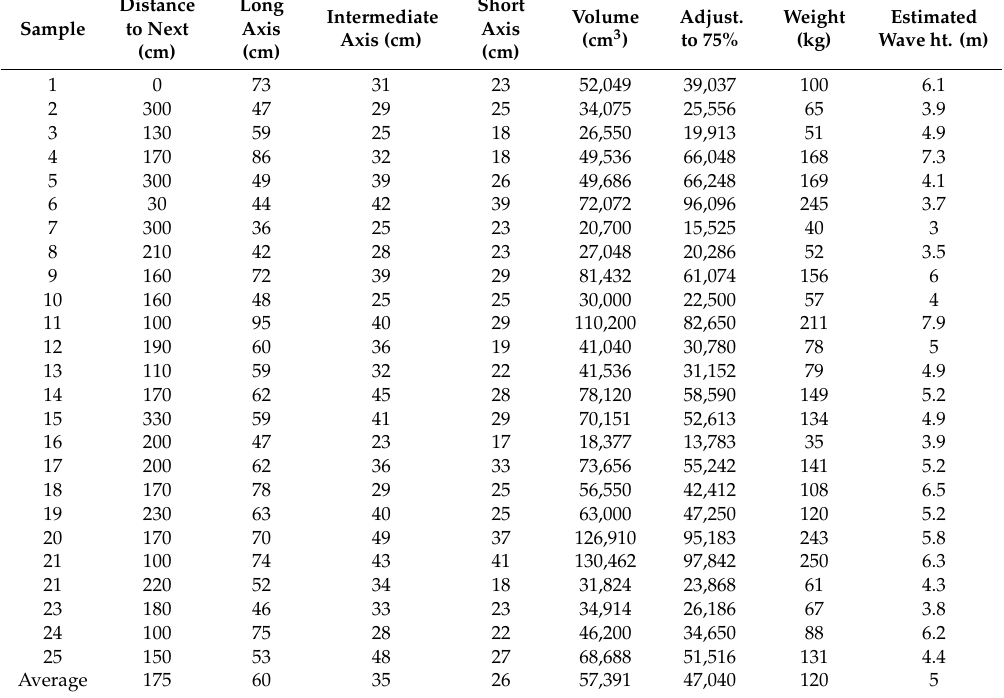
Table 2. Quantification of boulder size, volume and estimated weight from coastal bar samples through Transect 1b (continuation from 1a east of El China). The laboratory result for density at 2.55 gm / cm 3 is applied uniformly to all samples in order to calculate wave height for each